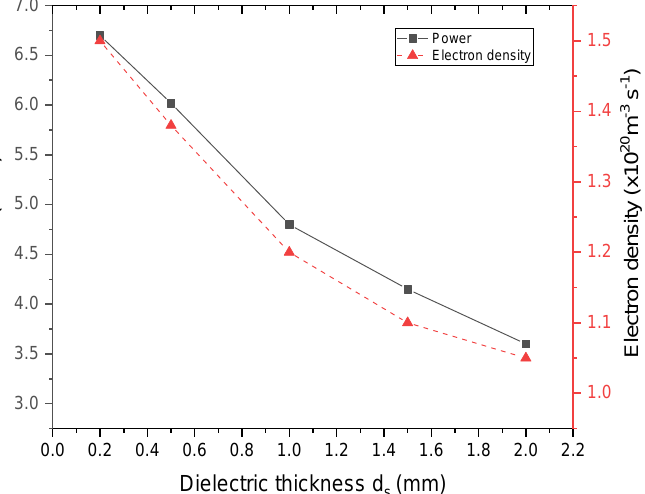
Figure 12. Evolution of electron number density N e and consumed power P with different dielectric thickness d s .